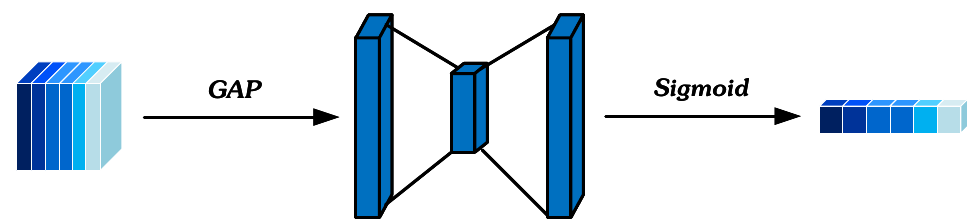
Figure 2. The structure of the SEWeight module. GAP represents global average pooling, each channel is downsampled to 1 × 1 × channel size, and the weight of the channel is adaptively obtained through two full connection layers.